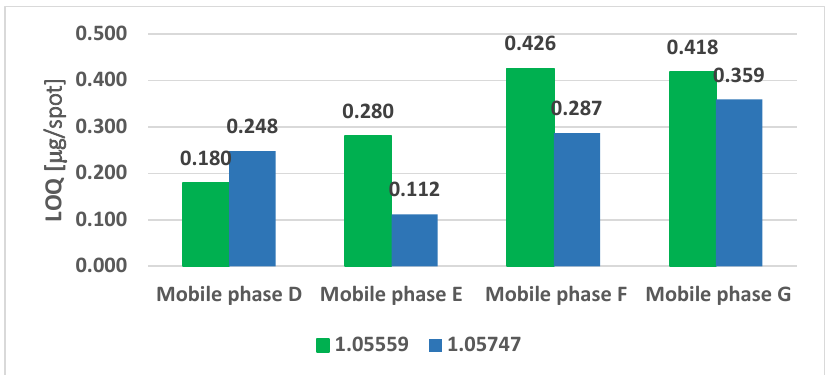
Figure 9. Mean values of the limit of quantification of sertraline, obtained by the method of partition thin-layer chromatography, where the mobile phases were as follows: D—methanol + water, 10:0 ( v/v ); E—methanol + water, 9:1 ( v/v ); F—acetone + water, 10:0 ( v/v ); G—acetone + water, 9:1 ( v/v ). The chromatographic plates were : 1.05747 — silanized silica gel 60F 254 (RP-2) on glass plates; 1.05559—silica gel RP- 18F₂₅₄ on aluminum plates.